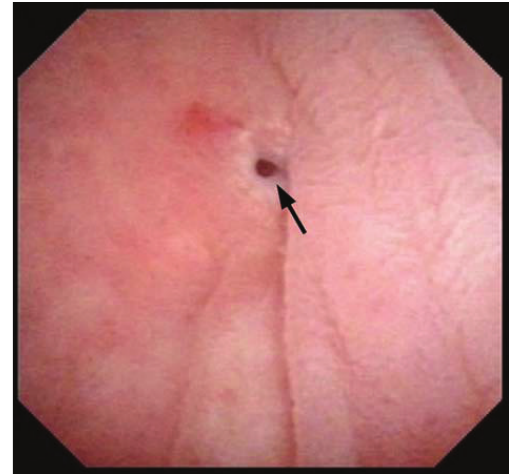
Figure 4: Flexible cystoscopy findings showing a pinhole (arrow) in the anterior wall of the ileal